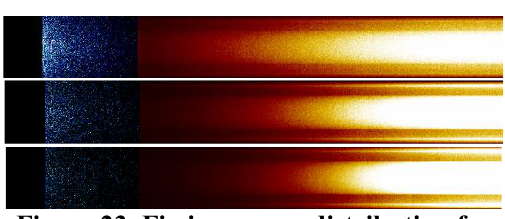
Figure 23. Fission power distribution for Maximum-diffusion case, ϒ=69%: burnup steps 40, 200, and 420 GWd/t (top to bottom).